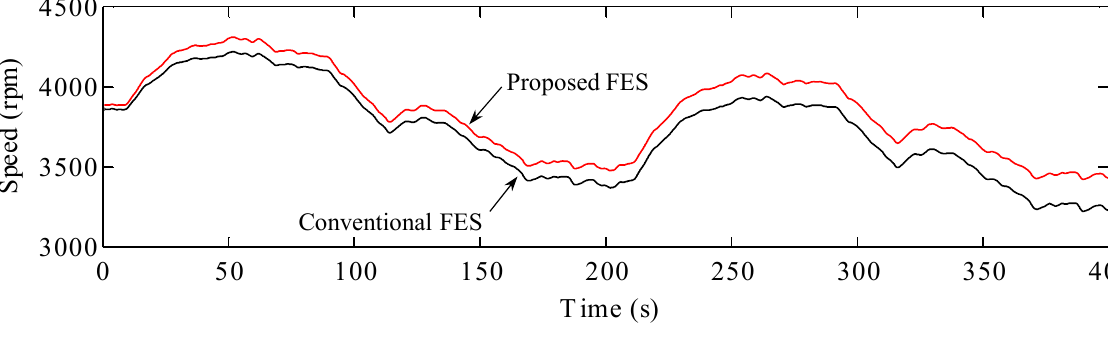
Figure 9. Speeds of the FES